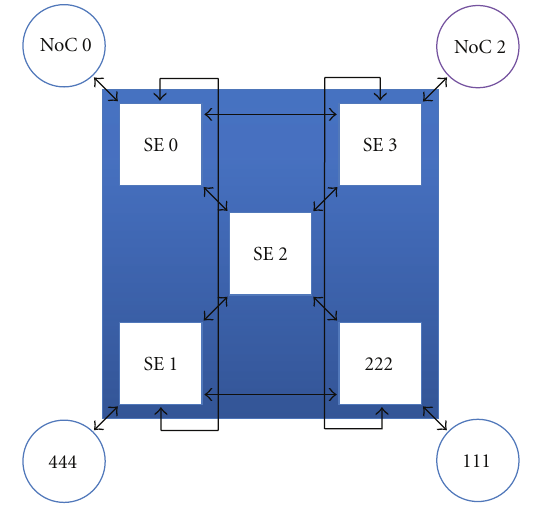
Figure 13: The simulation state of NiP-PNN model at first step of worst